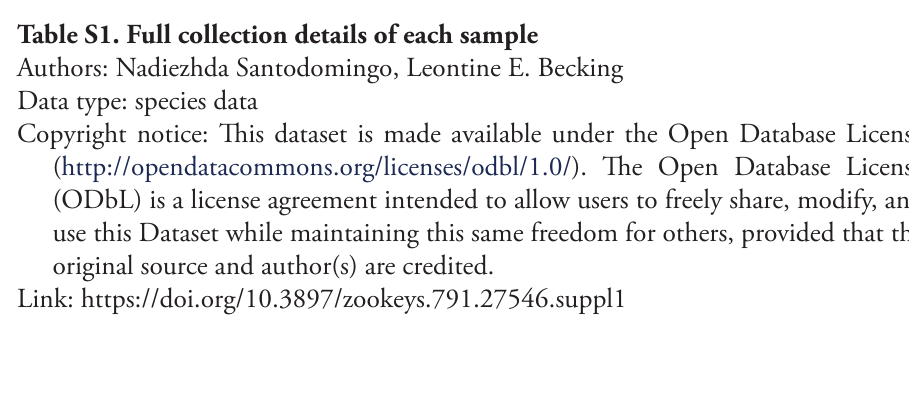
Table S1. Full collection details of each